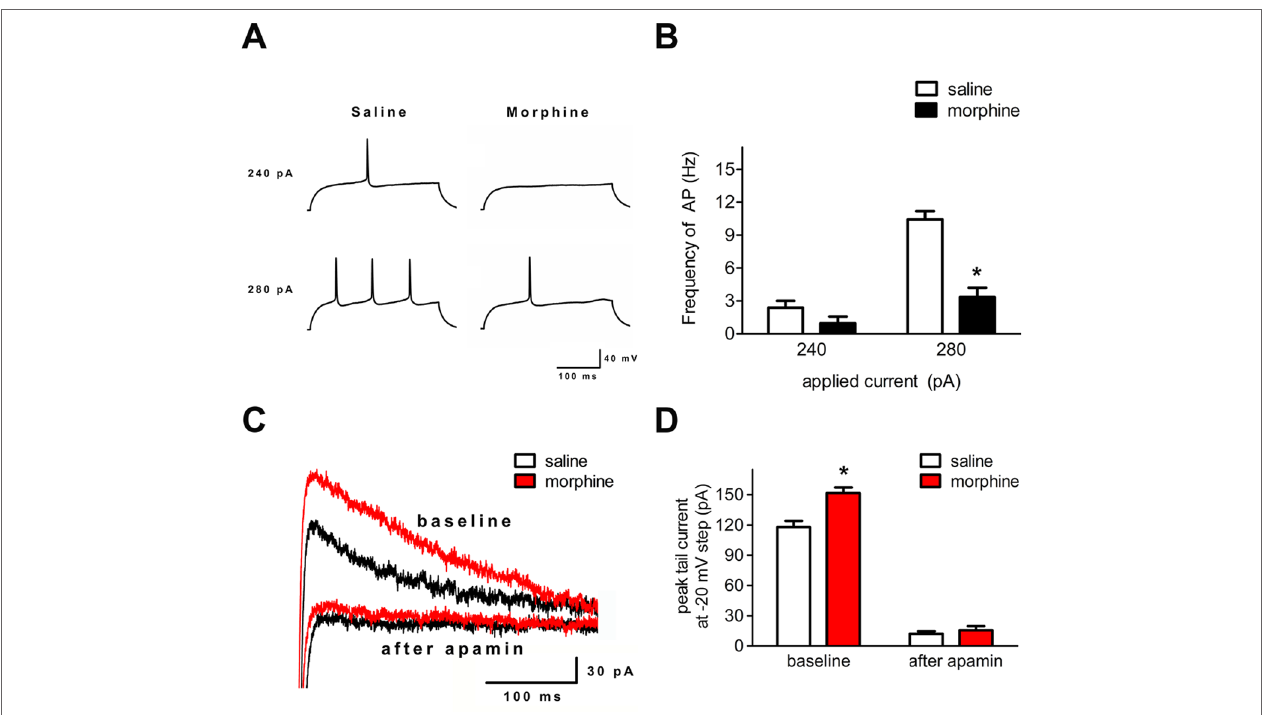
FIGURE 5 | Spike firing and SK currents were changed in layer 5 pyramidal neurons of the IL cortex after 3 weeks of morphine withdrawal. (A) Example traces of AP generation evoked in response to depolarizing current steps in pyramidal neurons from saline mock treatment rats or morphine withdrawal rats. (B) Grouped data showing reduced spike firing in neurons after 3 weeks of morphine withdrawal. The data are shown as means ± S.E.M., * p < 0.05 vs. saline. (C) Examples of magnified tail currents induced by depolarized to –20 mV from a –70-mV holding potential, after returning to –70 mV following the depolarization. (D) Grouped data showing that peak tail currents were increased in neurons from the morphine withdrawal group versus the saline mock treatment